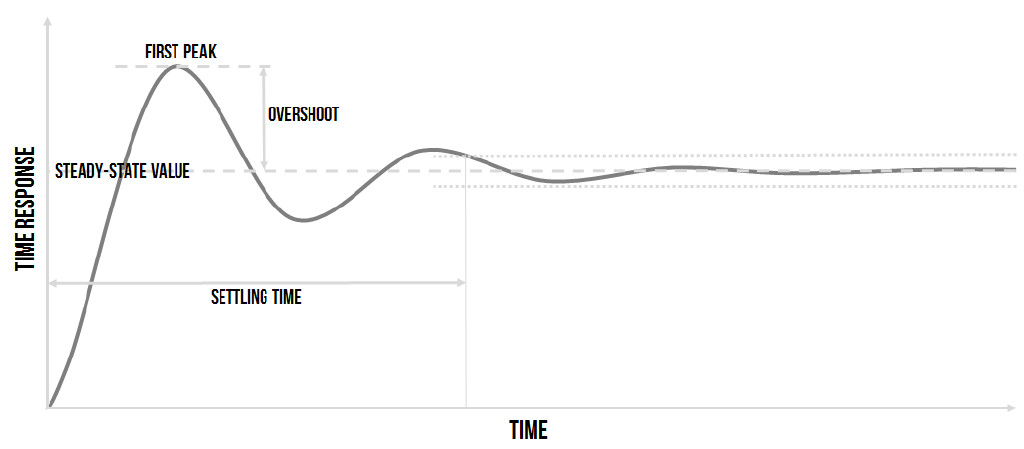
Figure 3. The depiction of the overshoot and the settling time in general